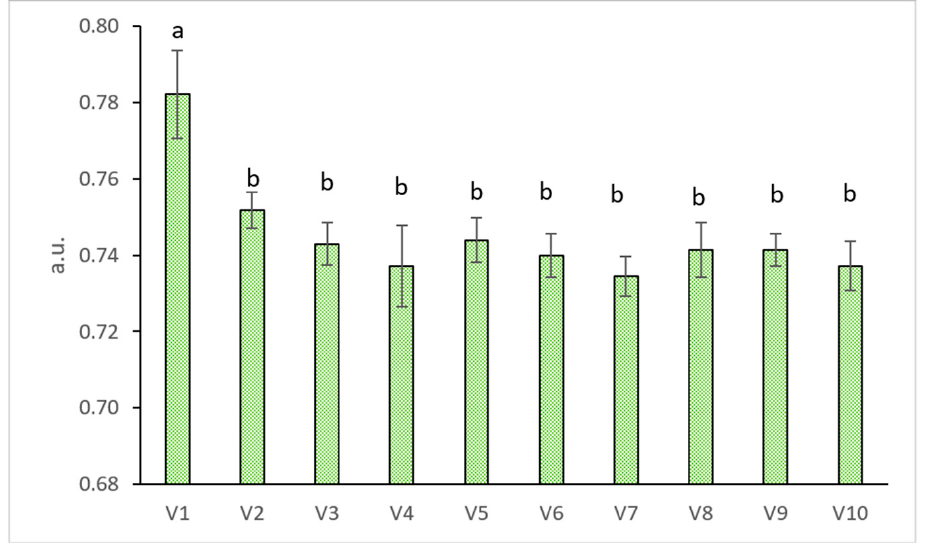
Figure 1. Chlorophyll fluorescence ( Φ PSII—quantum yield of PSII of light adapted leaves) of wheat grass cultivated on pond sediment. The values represent the mean ± standard error. The lowercase letters represent a statistically significant difference (Tukey Test, p < 0.05). a.u.: arbitrary units.